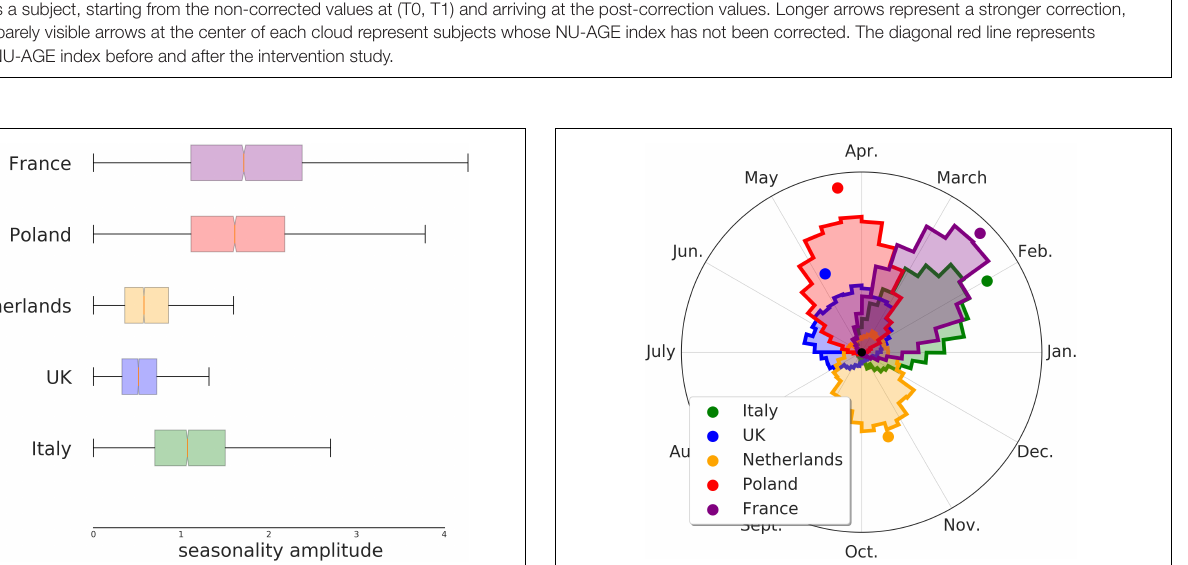
FIGURE 6 | Seasonal amplitude of the variation of NU-AGE index according to country. This represents the amplitude of maximum variation (above and below the yearly average) for the seasonality effect, independently from the estimated period of higher compliance. The difference among the countries is significant. In particular, the NU-AGE index in both England and the Netherlands seems to have a lower seasonal variability compared to the other countries.